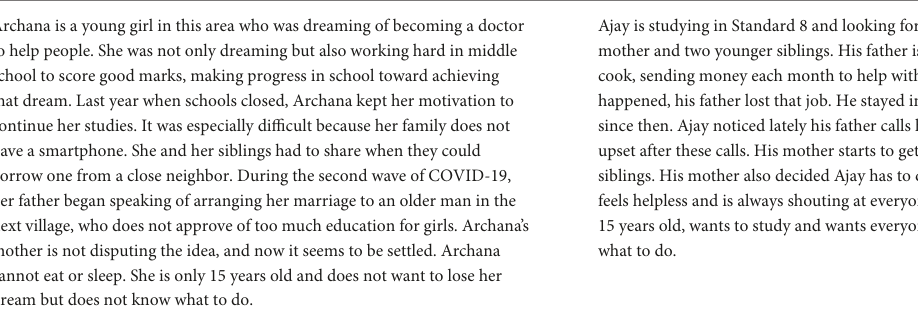
TABLE 1 English translations of vignettes used for study focus group